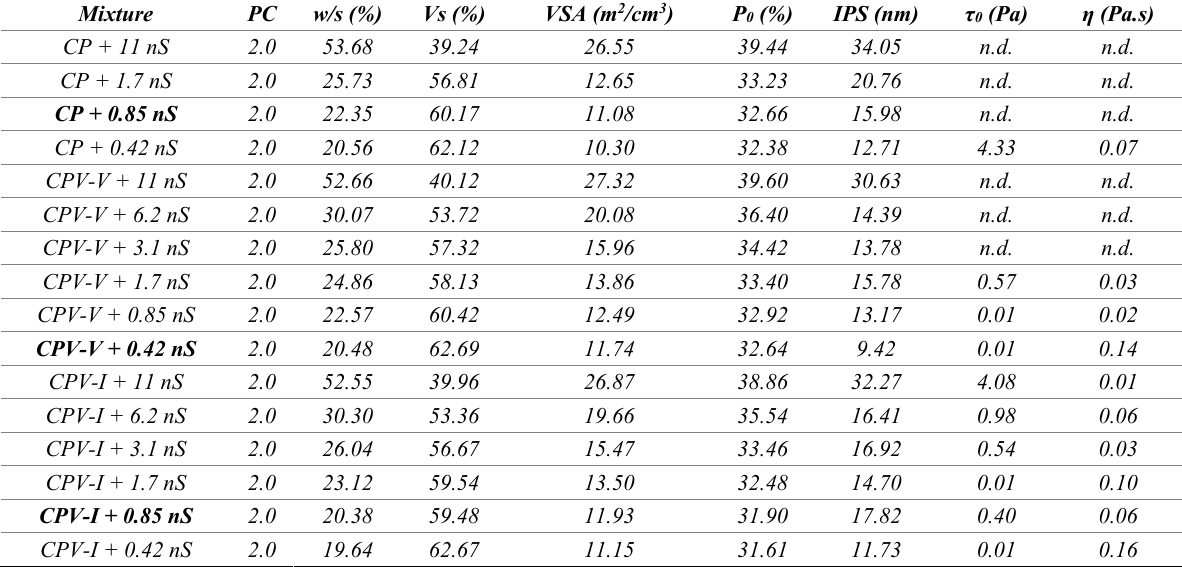
Table 3. Composition and physical characteristics of suspensions